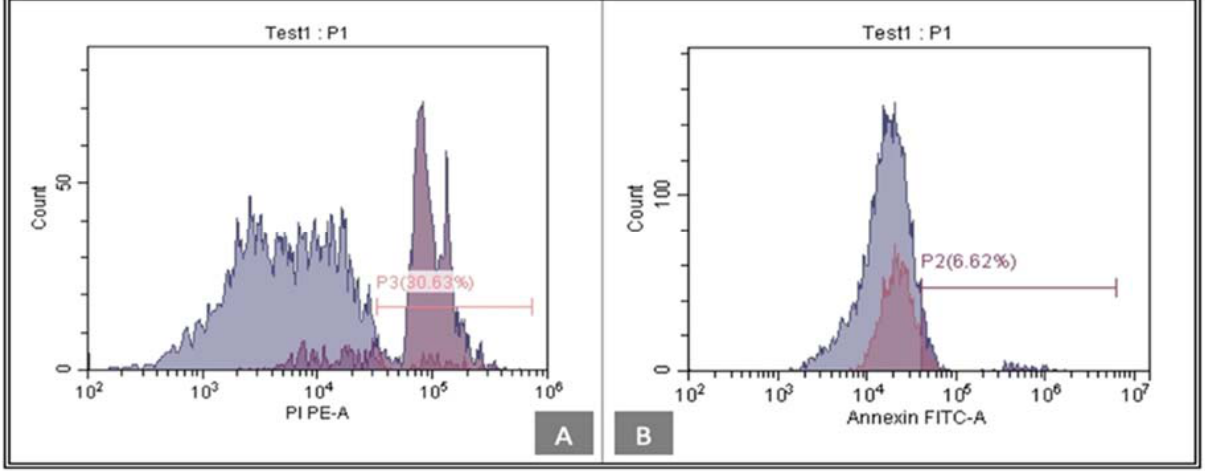
Figure 6. ( A ) Annexin ‐ V analysis by flow cytometry was used to analyze apoptosis in tideglusib group. ( B )The percentage of apoptotic cells was 6.62%. FITC, fluorescein isothiocyanate.